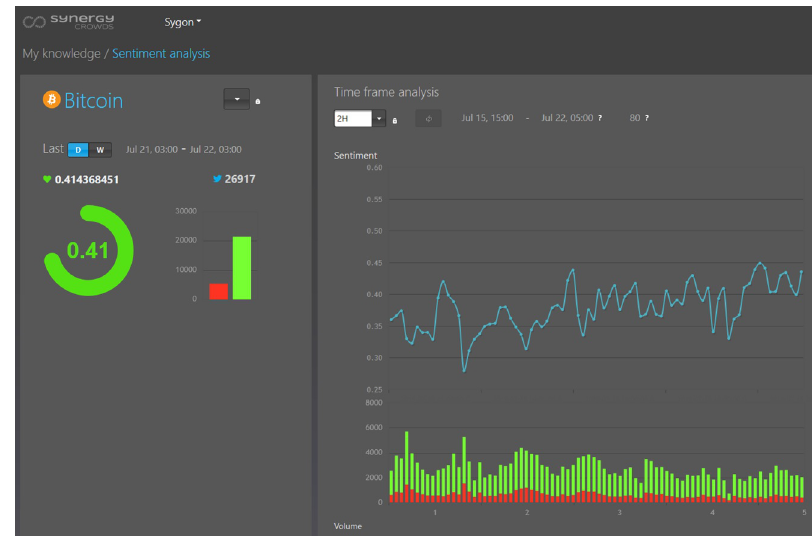
Figure 11. Sentiment indicator GUI within SynergyCrowds platform.